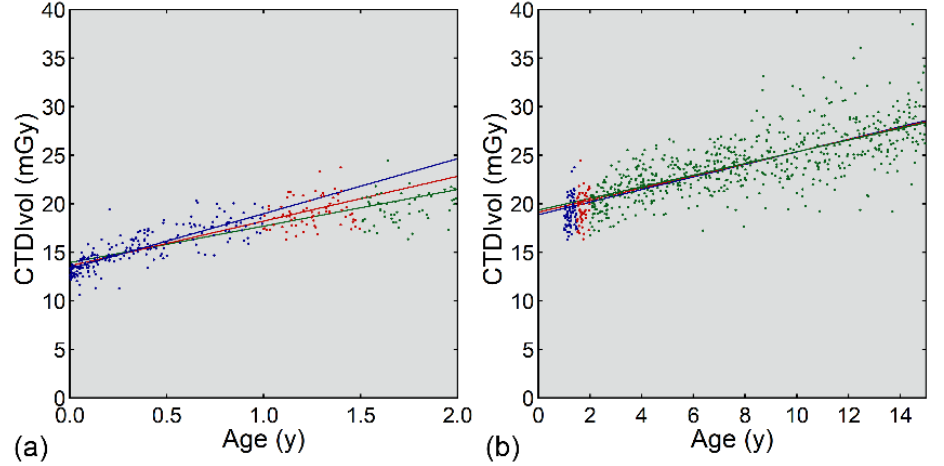
Figure 2. Linear regression analysis of CTDIvol and age for <2 years ( a ) and ≥ 1 year ( b ). In panel ( a ), the blue, red, and green plots represent data of 0–<1, 1–<1.5, and 1.5–<2 years, respectively. In panel ( b ), the blue, red, and green plots represent data of 1–<1.5, 1.5–<2, and 2–<15 years, respectively. The blue, red, and green lines are regression lines determined using young/old cutoffs of 1, 1.5, and 2 years, respectively. For example, with a cutoff of 1.5 years, linear regression was performed using the blue and red plots in the young range ( a ) and the red and green plots in the old range ( b